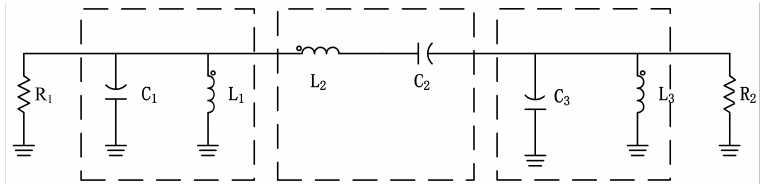
Figure 3. The structure of Band-Pass filter